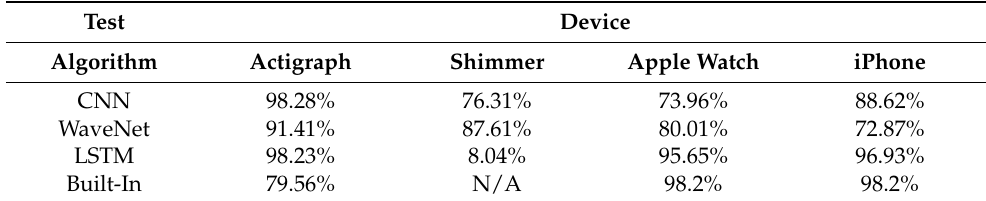
Figure 8. Results of testing the general models on an independent dataset using raw acceleration. Each dot correspond to one subject (blue dots indicate data in [38]). Table 1. Step-count accuracy of testing general models on independent dataset using raw